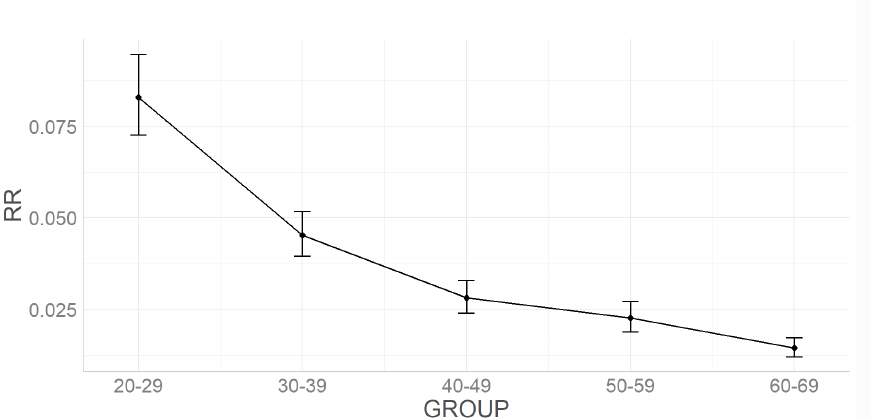
Figure 3. Mean and confidence intervals of VAG signal parameters in the further decades of life —for RR .